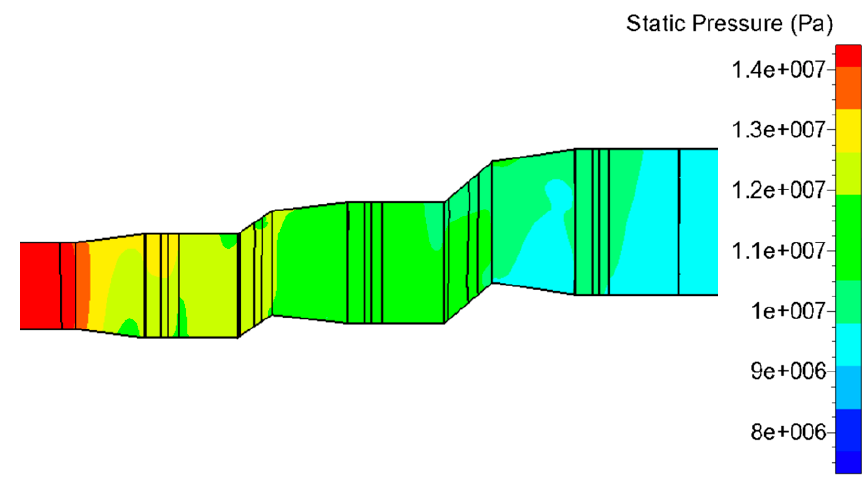
Figure 8. Static pressure distribution on the meridian plane.